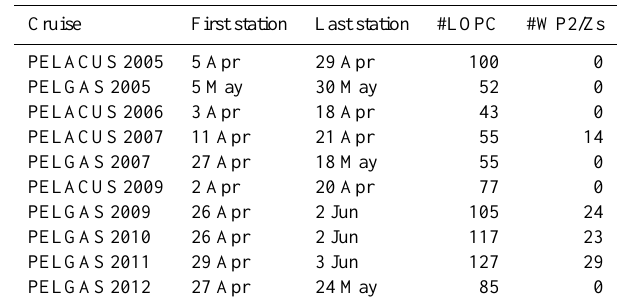
Table 1. Number of stations with LOPC and/or WP2/Zs data per cruises. There is a total of 816 LOPC profiles and 89 WP2 net sam- ples analyzed with the ZooScan. The table also shows the start and end dates of the